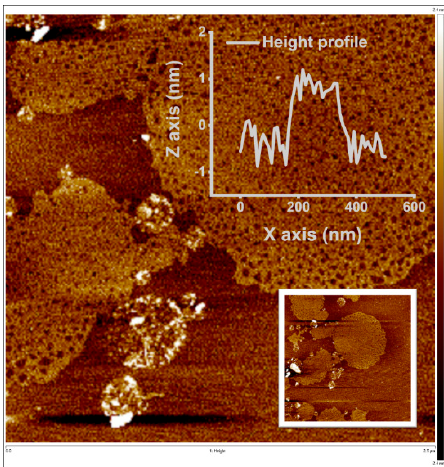
Figure 2. Atomic force microscopy (AFM) images showing individual MXene sheets ( ∼ 1 nm) observed in MXene solution after a week of storage in an aqueous solution, accompanied with a slight change in colour, most likely due to progressive oxidation and delamination. To prevent this from affecting the measurements, freshly prepared MXene solutions were used for every experiment.